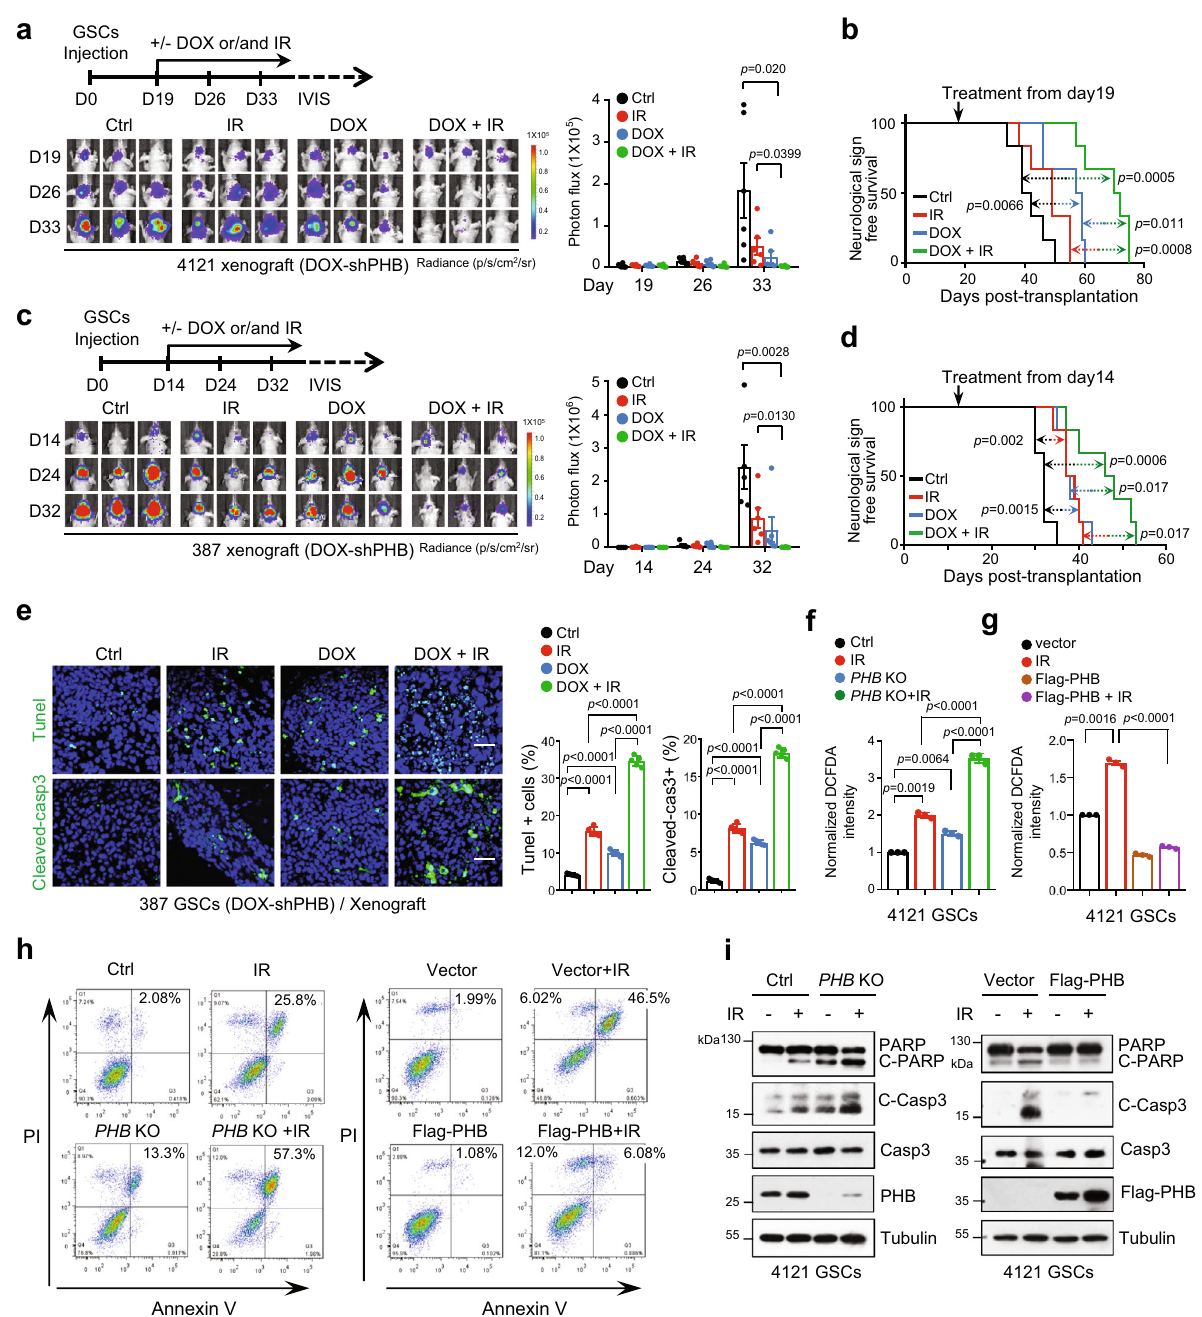
Fig. 5 PHB promotes GSC radio-resistance. a – d Nude mice (nu/nu) were intracranially implanted with GSCs ( a , b , 4121 GSCs; c , d 387 GSCs) transduced with Luciferase/Tet-on-inducible-shPHB. Mice were randomly grouped ( n = 6 for each group) and treated with control, IR (3 Gy, once a week, 4 times), DOX (2 mg/ml in drinking water), or the combined treatment from day 19 ( a , b ) or day 14 ( c , d ) after implantation, as shown by schematic representation ( a , c top). GBM xenografts were tracked by bioluminescence and the representative images are shown ( a , c bottom). Bioluminescent quanti fi cations of tumor growth are shown ( a , c right, mean ± SEM, unpaired two-sided Student ’ s t- test). Kaplan – Meier survival plots of mice are shown ( b , d ; Log-rank Mantel – Cox test). e IF staining of Tunel (top) or cleaved-caspase3 (bottom) in GBM xenografts from ( c ) are shown (left). Quanti fi cations of Tunel + or cleaved-caspase3 + cells are shown (right) (mean ± SD, n = 5, biologically independent samples, Unpaired two-sided Student ’ s t- test). Scale bars, 40 μ m. f , g The peroxide levels, as indicated by DCFDA fl uorescence, were measured by fl ow cytometry in 4121 GSCs with indicated treatments. IR, 3 Gy for 48 h ( f ) or 72 h ( g ) (mean ± SD, n = 3, biologically independent experiments, Welch ’ s two-sided t- test). h Cell apoptosis was measured by fl ow cytometry in 4121 GSCs with indicated treatments. IR, 3 Gy for 48 h (left) or 72 h (right). i IB showing levels of cleaved-PARP, cleaved-caspaspe3, caspase3, and PHB in GSCs with indicated treatments. IR, 3 Gy for 48 h (left) or 72 h (right). Source data are provided as Source Data fi